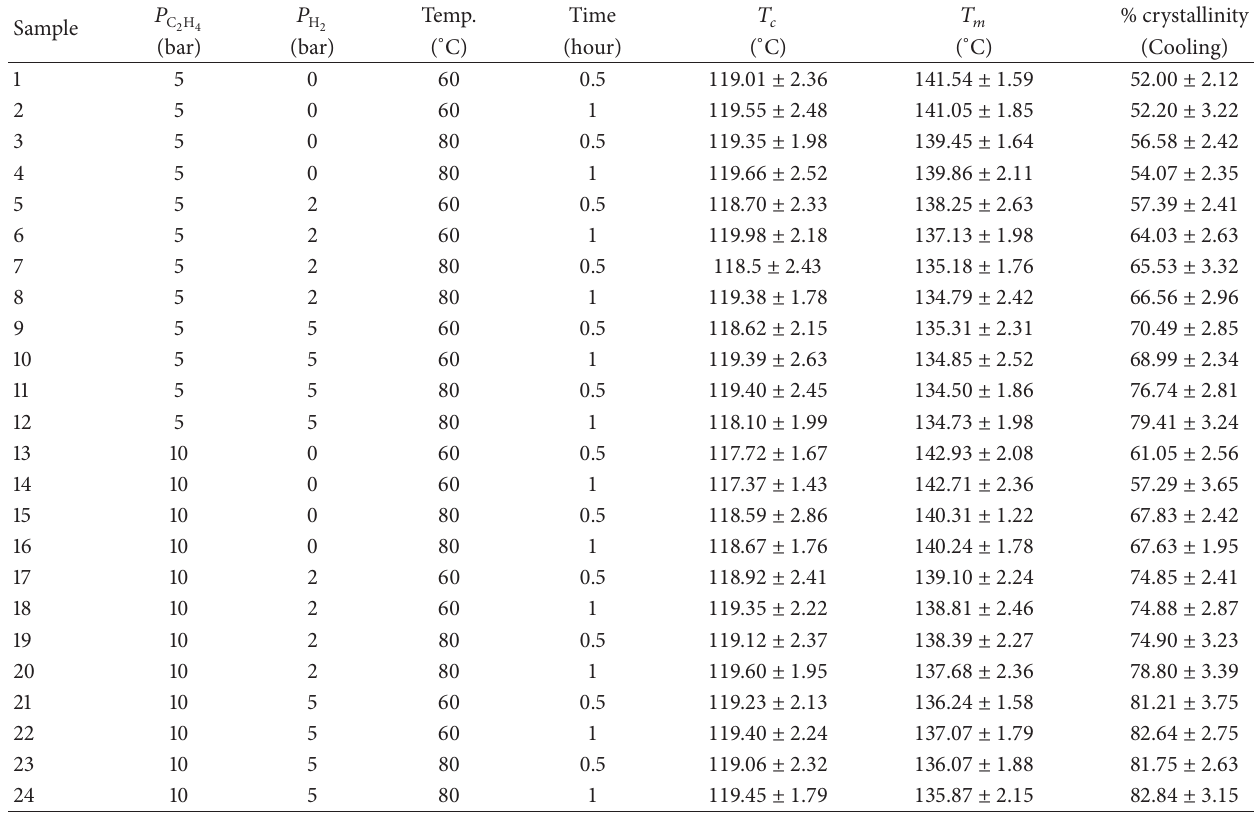
Table 3: DSC analysis for polyethylene